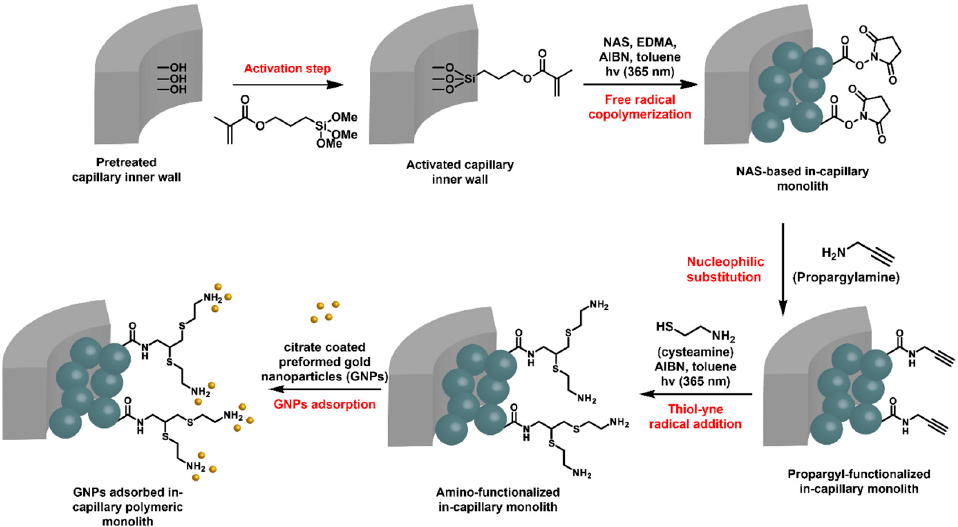
Figure 8. Strategy adopted for the preparation of hybrid in-capillary systems for flow through catalytic applications. [88].